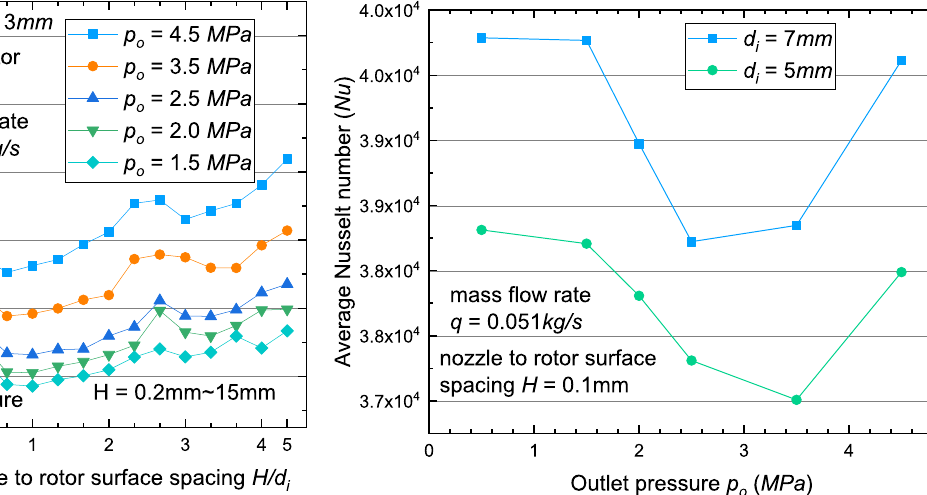
Fig. 8. Effect of H / d i ( d i =3mm) on the Nu with different outlet pressure p o .